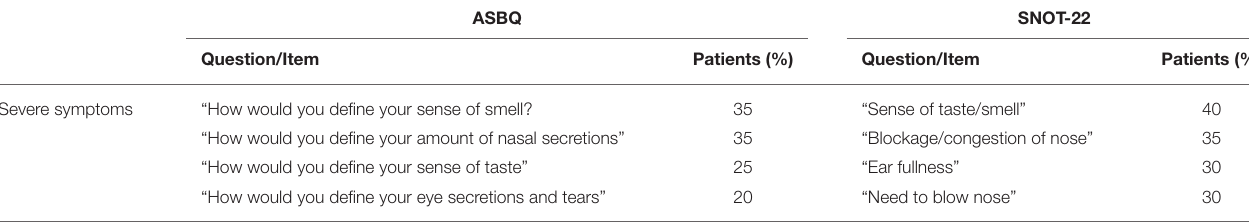
TABLE 5 | The items of ASBQ and SNOT-22 with severe symptoms after 1 year follow-up of patients.